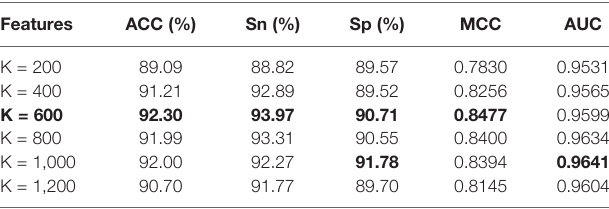
TABLE 5 | The effect of different feature extraction methods on the training set of pupylation sites. Features